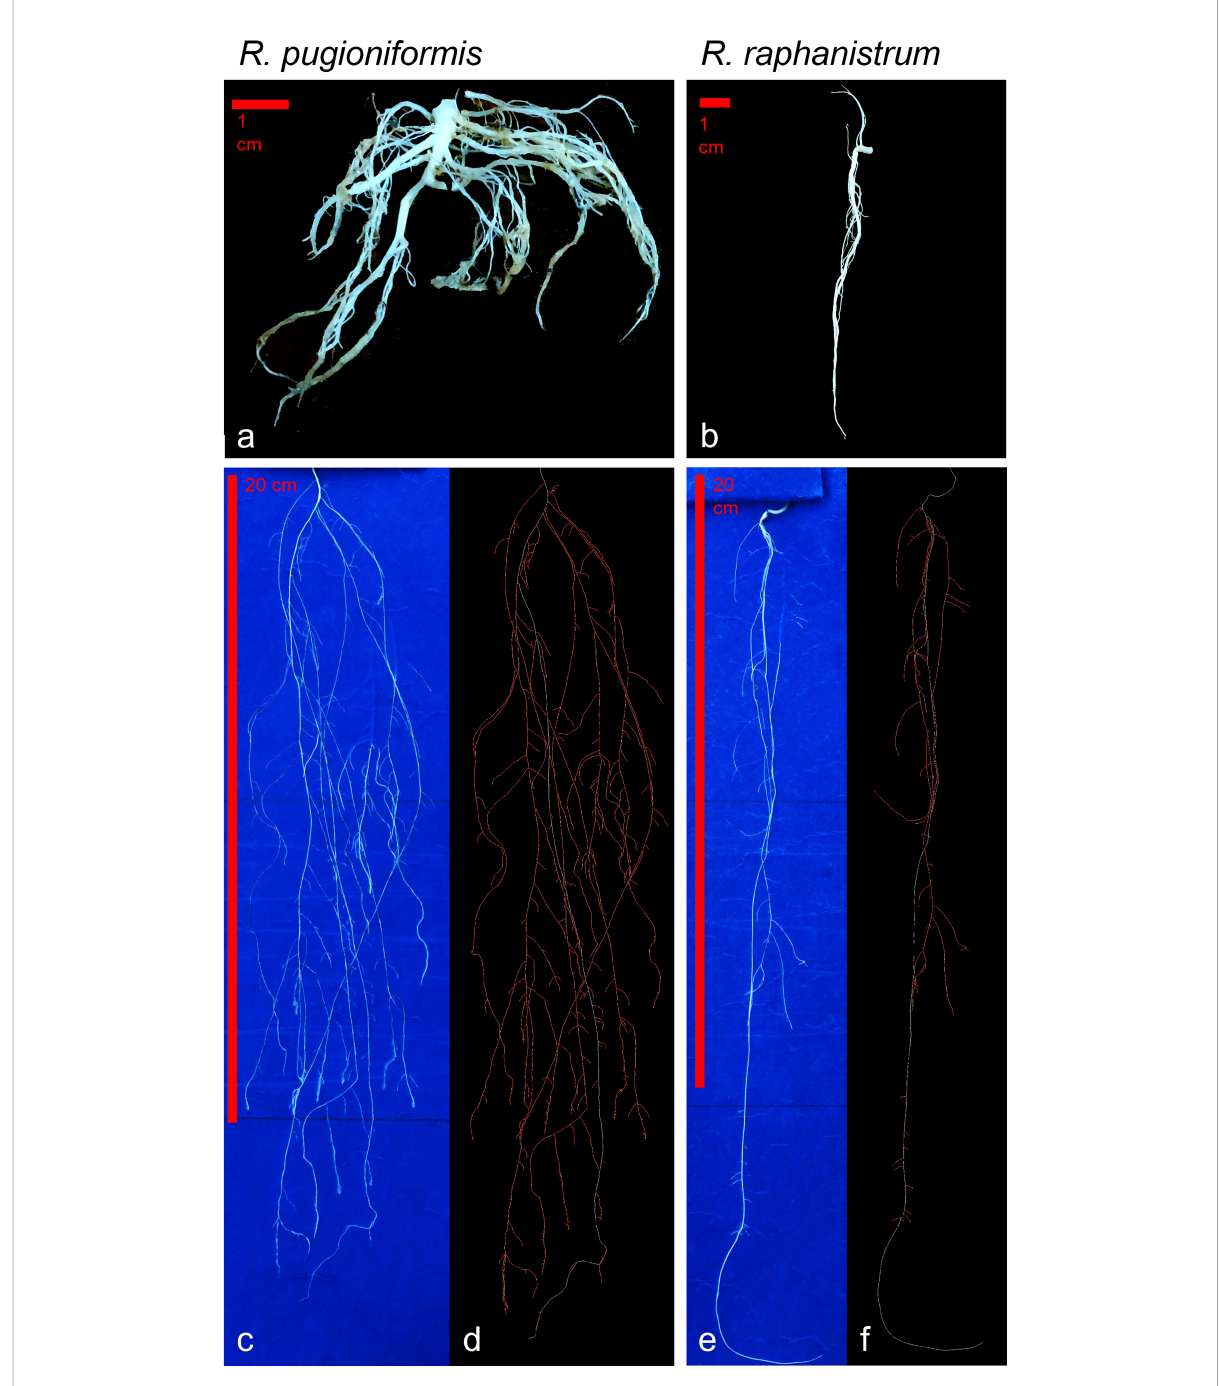
FIGURE 5 Root architecture differs between R. pugioniformis and R. raphanistrum . (A) Representative root architecture of R. pugioniformis grown on Terra Rossa soil, showing a short main root with elaborate lateral root system. (B) R. raphanistrum grown on Hamra formed a long main root and few lateral roots. The plants were harvested after bolting (approximately 70-80 days after germination) following growth in natural conditions with individual pots in Palestine (see Figure 2). Representative root architectures of R. pugioniformis (C) and R. raphanistrum (E) after 21 days of controlled growth on modi fi ed root growth media (Hoagland & Knop medium), mimicking native soil nutrient composition of Terra Rossa and Hamra for R. pugioniformis and R. raphanistrum , respectively. Digital pro fi ling of the corresponding roots after analysis with EZ-Rhizo II [ R. pugioniformis , (D) ; R. raphanistrum , (F) ], which enables quantitative analysis of root architecture and growth kinetics. The main root is traced as white line, while all the lateral roots are drawn in